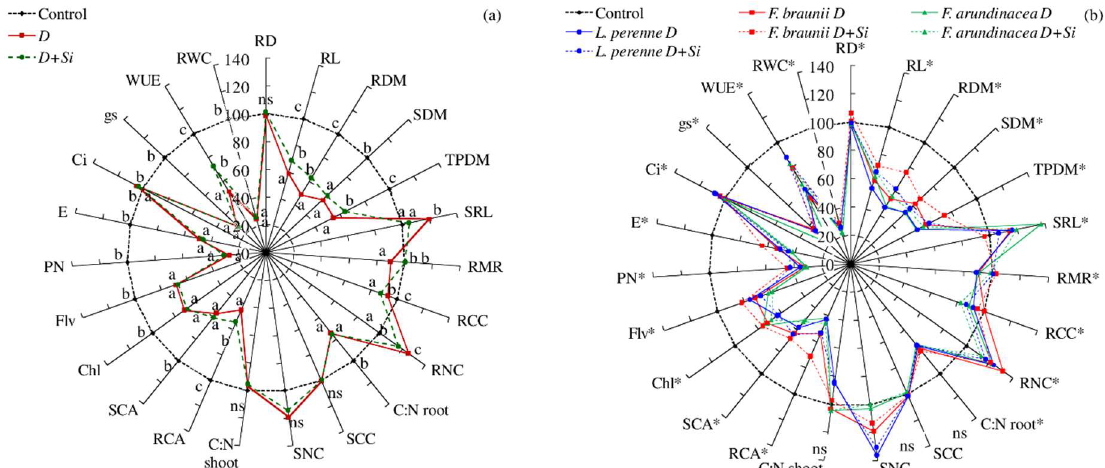
Figure 4. Variability of the values of the examined features depending on the drought (D) and application of silicon before drought (D + Si) (% in relation to control—C); ( a ) mean values of features irrespective of the species and cultivars and ( b ) mean values of features for the tested species ( F. braunii , F. arundinacea , L. perenne ) under the water and Si conditions (C, D, and D + Si); Chl—content